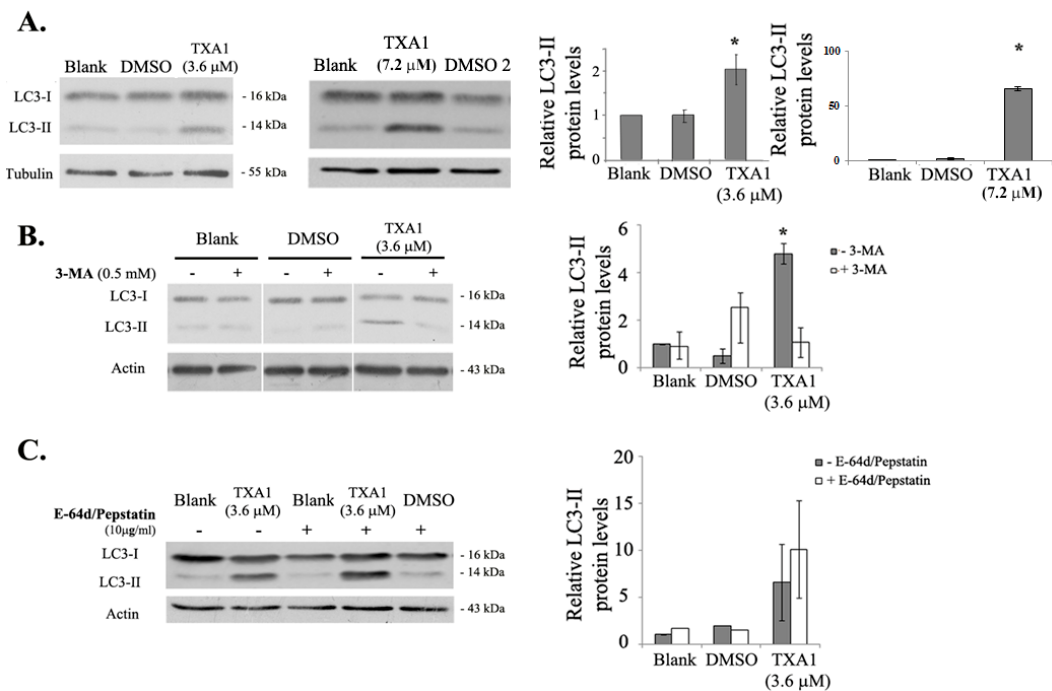
Figure 5. Effect of TXA1 on the expression levels of LC3-II in A375-C5 cells. Cells were treated for 48 h with medium (blank), TXA1 (3.6 μ M or 7.2 μ M), or with the corresponding DMSO concentrations (DMSO or DMSO2, respectively) LC3-II protein levels were analyzed by Western blot. ( A ) Following treatment with TXA1 alone; ( B ) following co-treatment with 3-MA; and ( C ) following co-treatment with E-64d/pepstatin. Images are representative of, at least, three independent experiments (except for the case of blank and DMSO treatments in the presence of E-64d/pepstatin, which result from two experiments only). Results of the densitometry analysis are expressed after normalization of the values obtained for each protein with the values obtained for tubulin or actin (and further expressed in relation to blank cells) and represent the mean ± SEM from, at least, three independent experiments (except for the case of blank and DMSO treatments in the presence of E-64d/pepstatin, which result from two experiments only). * p ≤ 0.05 Blank vs. treatment.